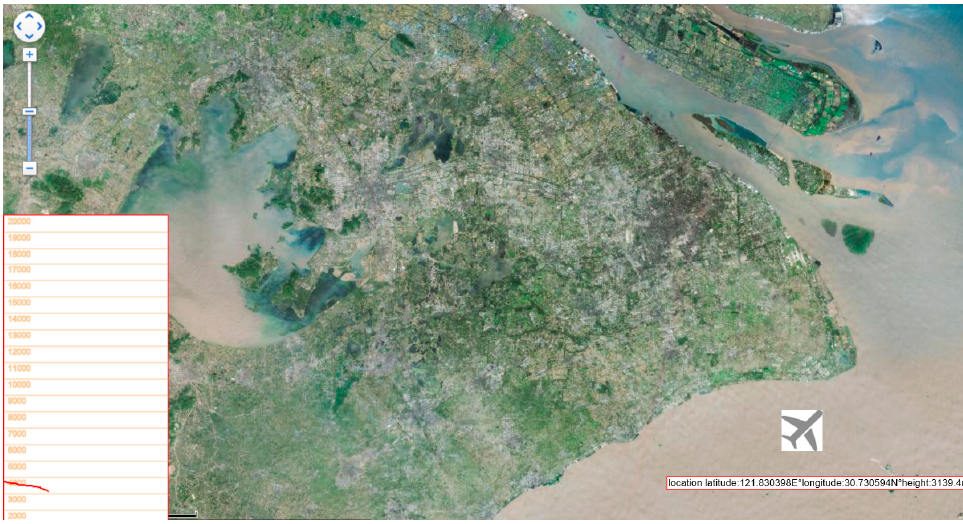
Figure 19. Airspace situation interface 2.